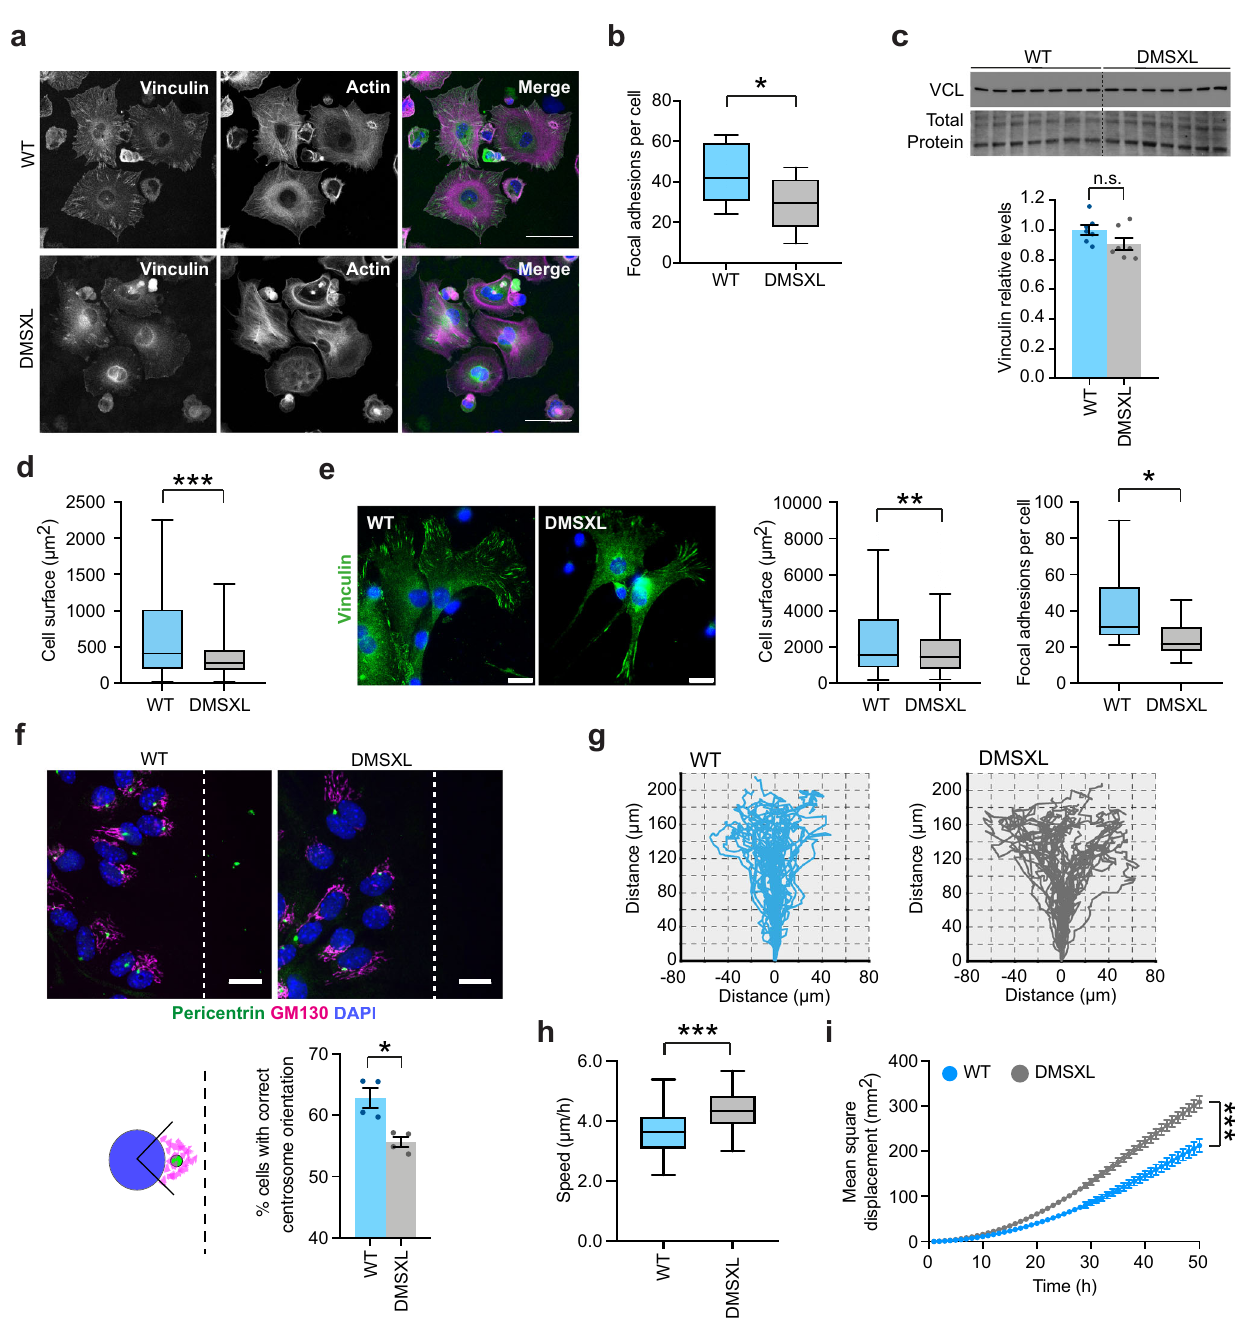
immuno fl uorescence staining of the Golgi apparatus and centrosome and found a mild but signi fi cant defect in astrocyte polarization (Fig. 4f). Overall while 62.8 ± 1.6% of WT astrocytes orientated their Golgi apparatus and centrosome perpendicularly correctly orientated. Next, we examined the impact of defective assembly of focal adhesions and cell reorientation on cell migration, by time-lapse videomicroscopy and tracking of the trajectories of individual astrocytes (Fig. 4g). DMSXL astrocytes migrated at a higher speed over 50 h of wound closure (Fig.